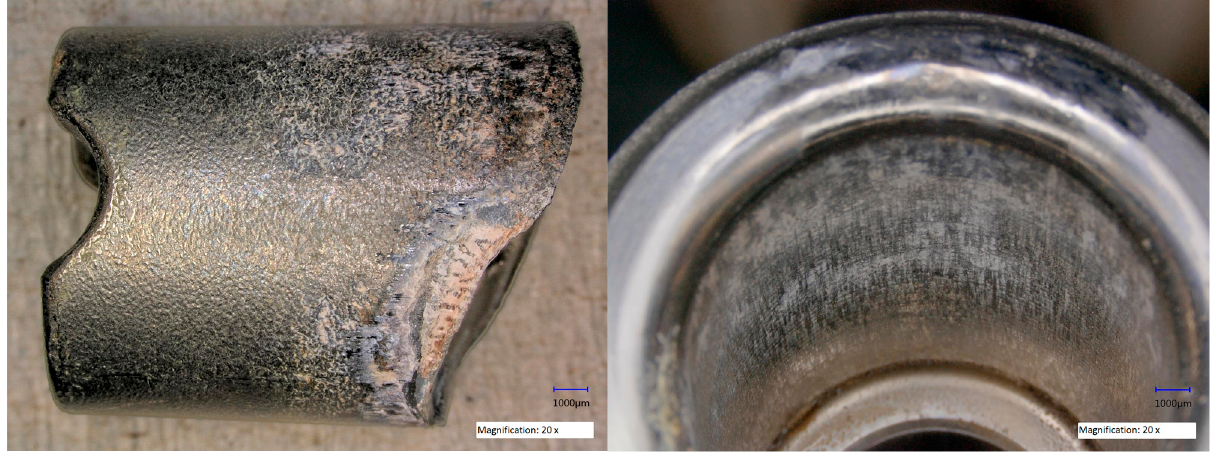
Figure 4. Neck ( left ) with broken proximal taper piece after disconnection ( right ).